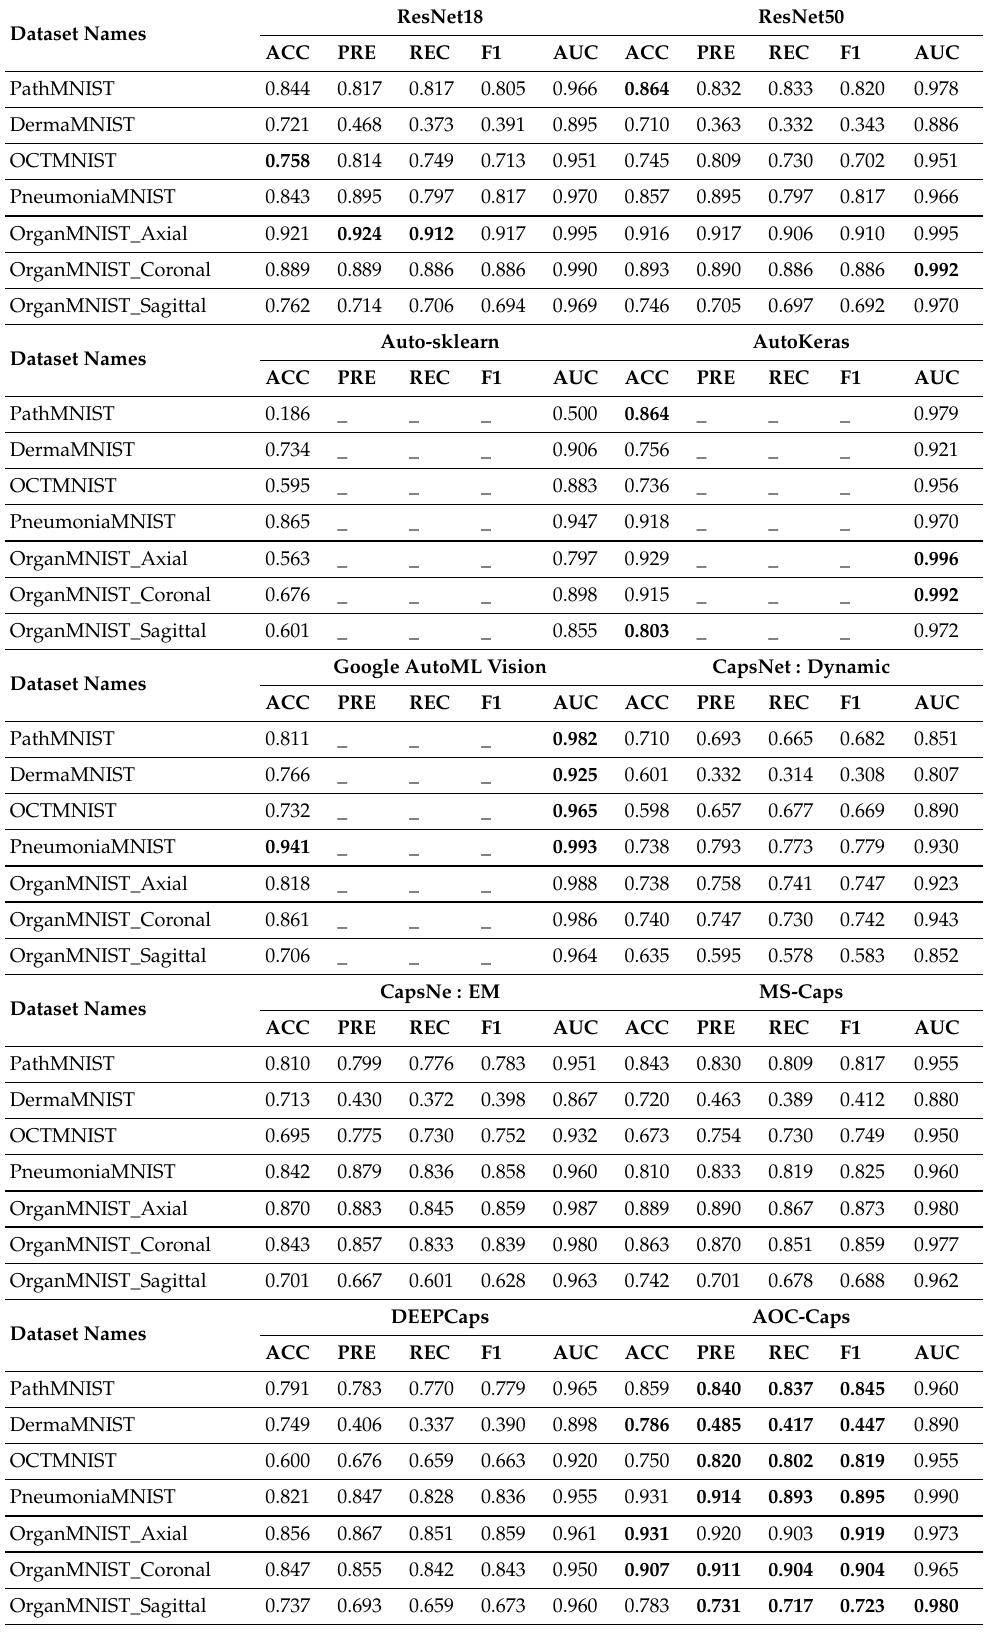
Table 12. Performance of seven datasets in